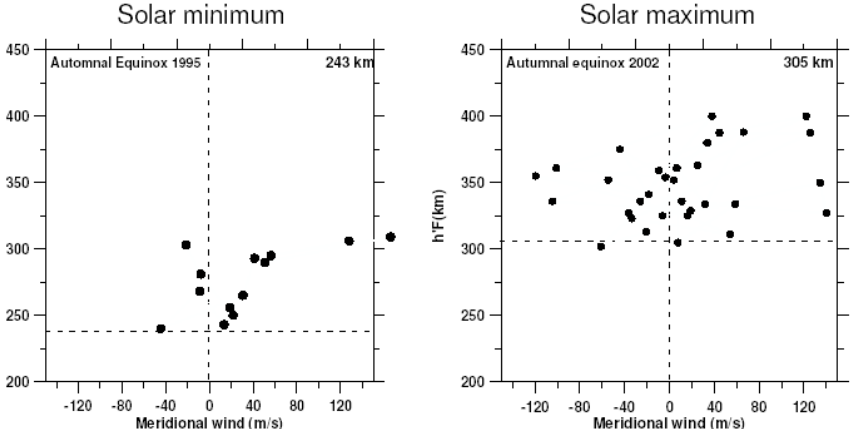
Fig. 3. Scatter plot of meridional wind and h 0 F prior to triggering of ESF for equinox of solar minimum (left panel) and solar maximum (right